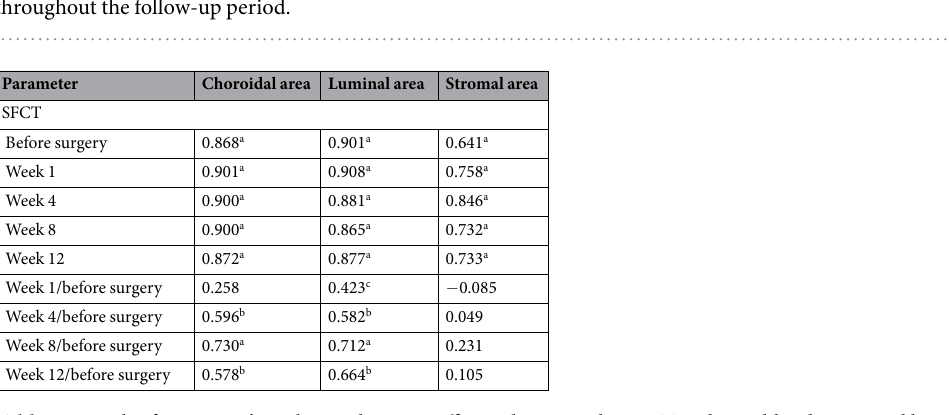
Figure 3. The mean subfoveal choroidal thickness (SFCT) at 1 week postoperatively was significantly thicker than that preoperatively in the operated eye (P < 0.001), while there was no significant change in the fellow eye throughout the follow-up period ( A ). The choroidal area ( B ), the luminal area ( C ) and the stromal area ( D ) at 1 week postoperatively were significantly increased compared with those preoperatively in the operated eye (P < 0.001, P < 0.001, P = 0.025, respectively), while there was no significant change in the fellow eye